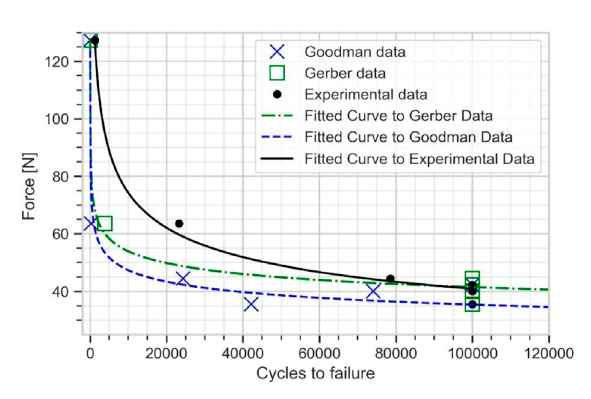
FIGURE 8 Force vs. number of cycles to failure curve for the plate from experimental data, Goodman, and Gerber mean stress correction using elastic FE